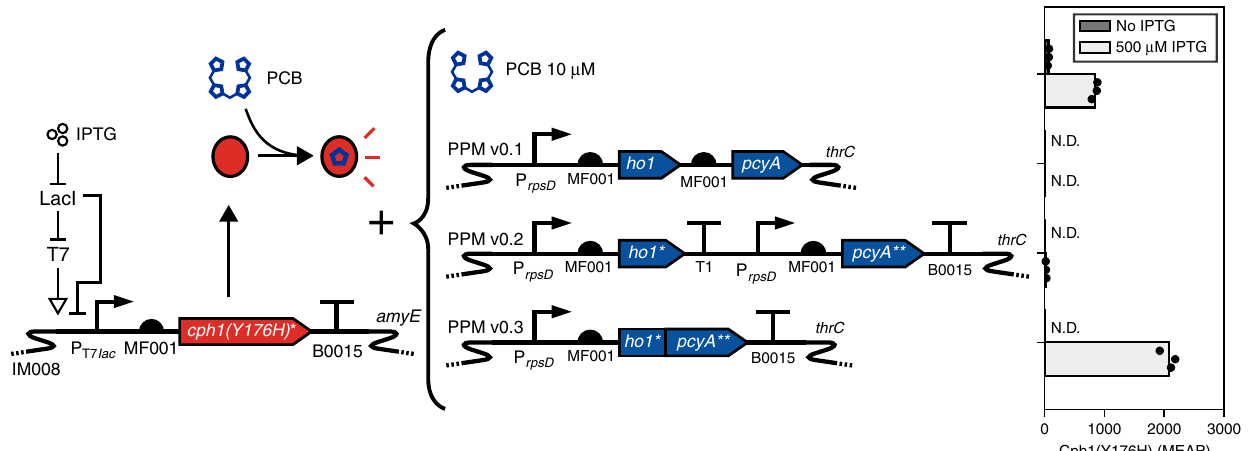
Fig. 2 Debugging and optimizing the PCB production module. B. subtilis expressing cph1(Y176H)* from LacI-T7 40 were grown in the absence or presence of IPTG, and in the presence of 10 µ M exogenous PCB, or in combination with PPM v0.1, v0.2, or v0.3. The resulting red fl uorescence of the Cph1(Y176H)- PCB conjugate was measured via fl ow cytometry. Bars show the mean of three experiments run on separate days. Black dots show values of individual experimental replicates. N.D.: not detected (see “ Methods ” section). Source data is available in the Source Data fi le